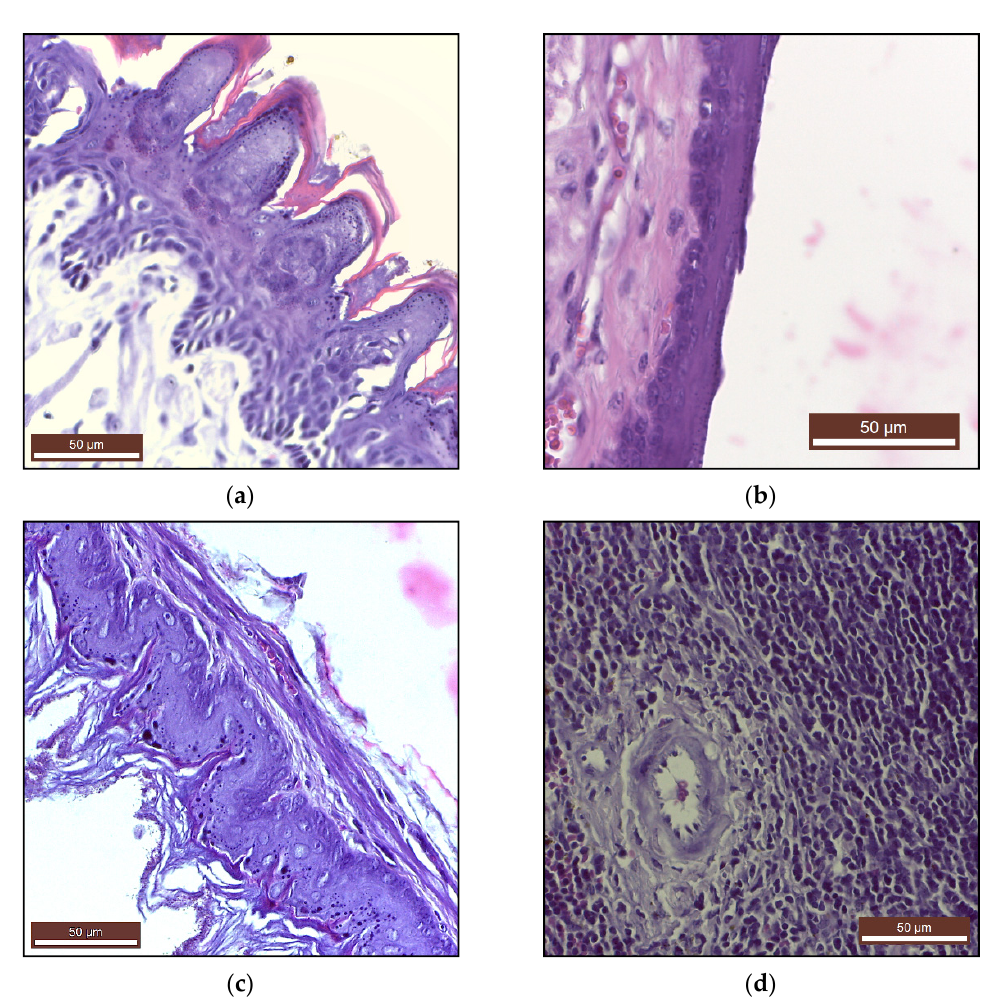
Figure 3. Tissue sections (Masson’s trichrome staining) of: ( a ) tongue, ( b ) esophagus, ( c ) keratinized gastric mucosa, ( d ) spleen.